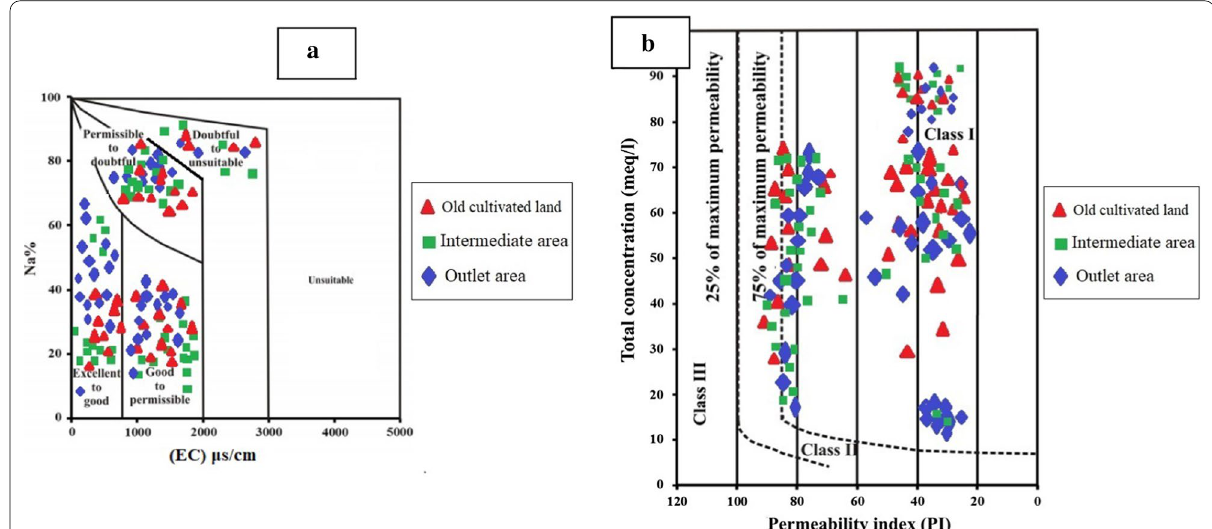
Fig. 15 Suitability of water for irrigation based on a salinity and SAR, b PI in the (red triangle) old cultivated land area, (blue diamond) outlet area and (green square) Intermediate